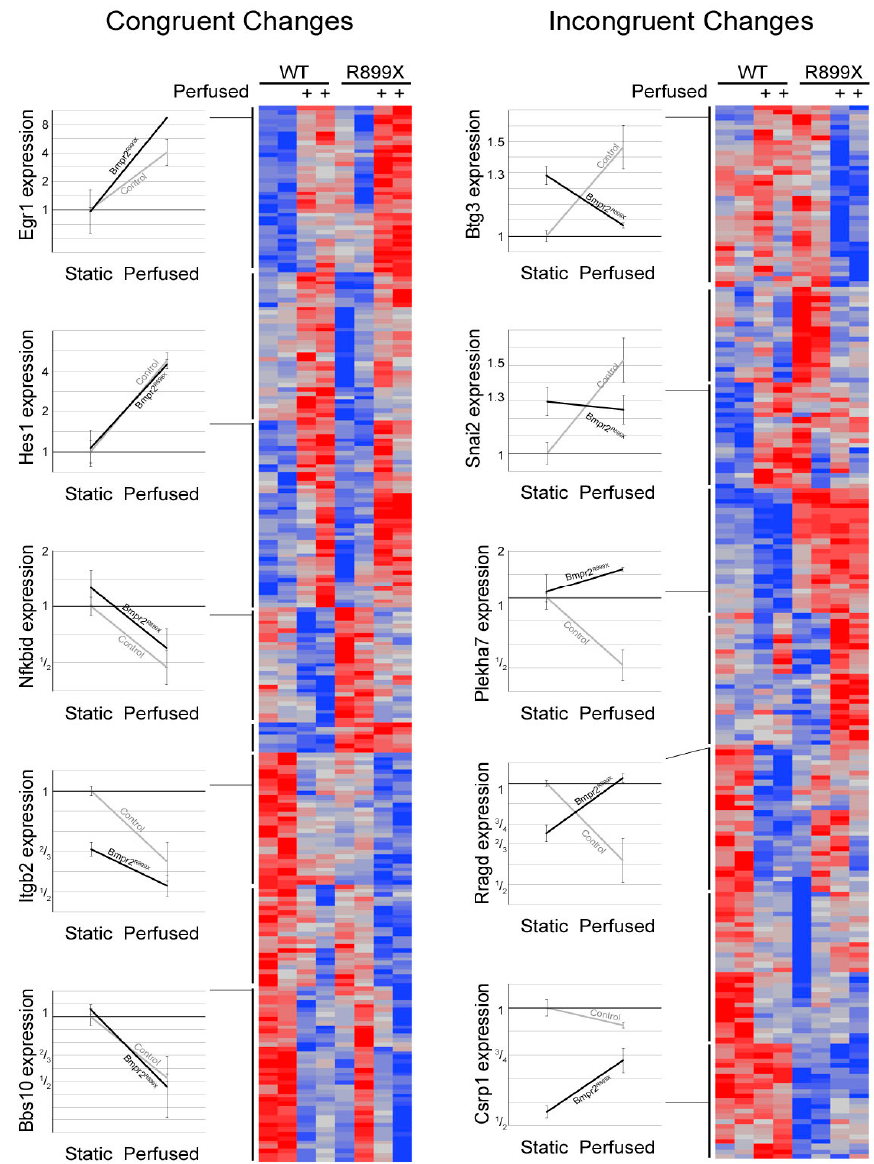
Figure 3. Congruent and incongruent heat map depiction of gene expression changes. Heat maps were separated by cell genotype (WT and Bmpr2 R899X ) with flow (+) or without flow. Representative genes and corresponding expression changes were selected to illustrate change in expression seen within the congruent and incongruent maps. Congruent genes had similar directional changes to flow but were offset by the magnitude of expression. Incongruent genes had opposite directional responses to flow that result in different magnitude changes. The inclusion of flow led to notable gene expression changes in both the R899X and WT endothelial cell. Notable changes in gene expression were seen between the cell’s genotype and flow conditions.